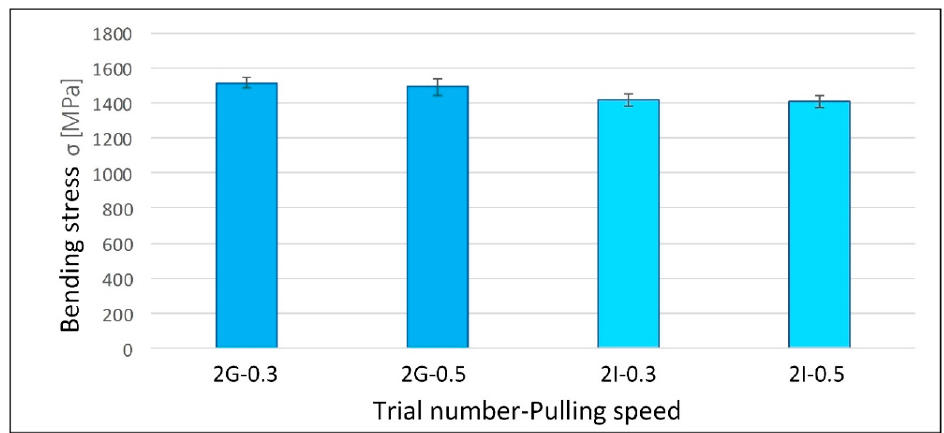
Figure 9. Bending stress for di ff erent pulling speeds and resin mixing times.